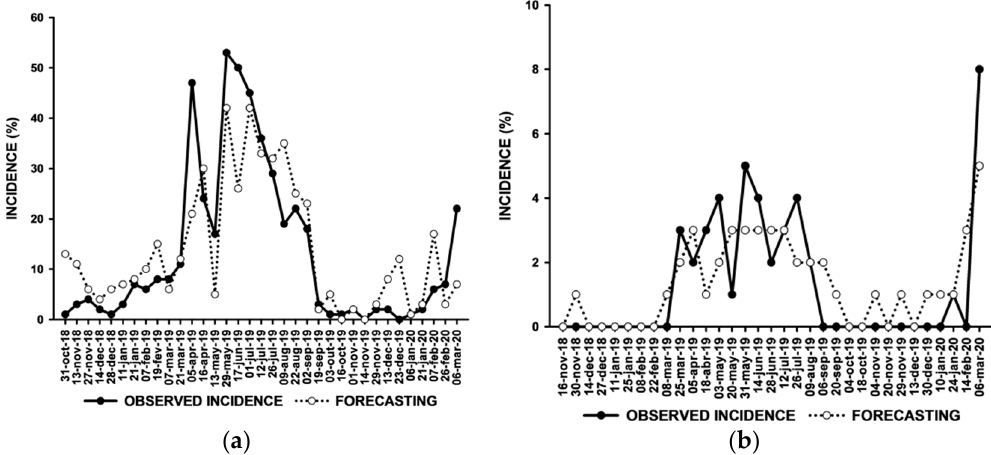
Agronomy 2021 , 11 , x FOR PEER REVIEW Figure 6. Coffee rust progress curve and prediction estimates from the models: ( a ) Carmo do Rio Claro model 15–30 DBRI (Days before rust incidence) excluding the Isolation time, Wind Speed, Dew point temperature and Wetness; ( b ) Nova Resende model 15–30 DBRI (Days before rust incidence) excluding Wind Speed and Dew point temperature.